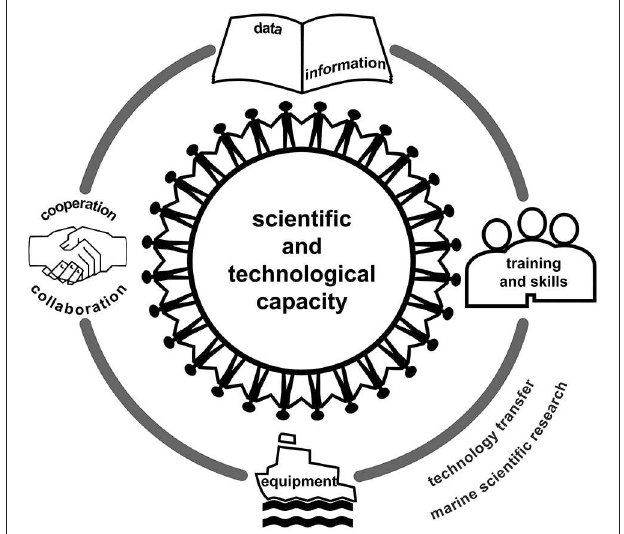
FIGURE 1 | A holistic approach to scientific and technological capacity. Several forms of technology transfer could collectively contribute to capacity building, including data and information; training and skills; equipment and research infrastructure; and cooperation and collaboration. Marine scientific research drives such